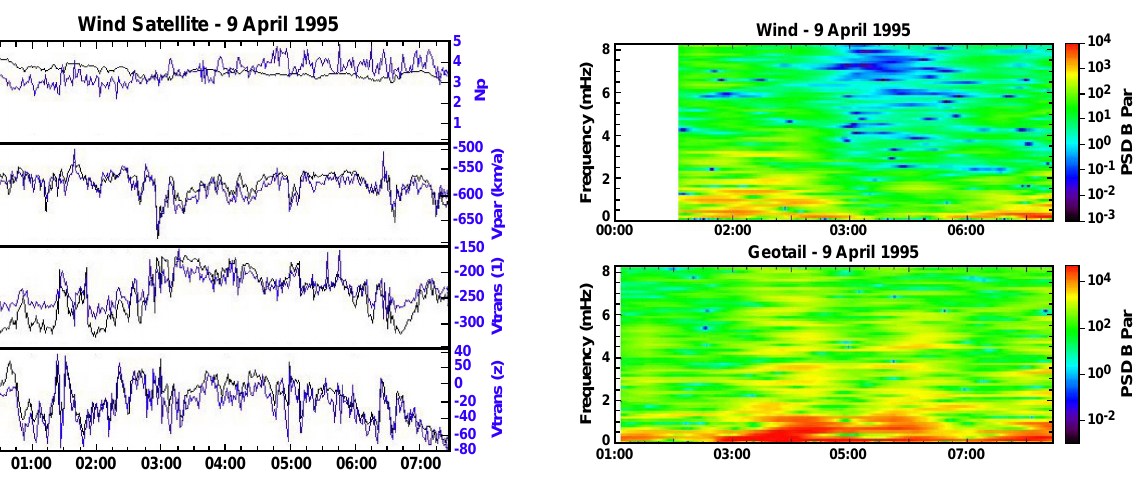
Fig. 16. PSD for Wind (top panel) and Geotail (bottom panel) on 9 April 1995. field magnitude. Each of the components of magnetic field and velocity are correlated (bottom three panels of Fig. 14) but the correlation is not perfect. In the magnetosheath in Fig. 15 the amplitude of the fluc- tuations is increased and the fluctuations are less